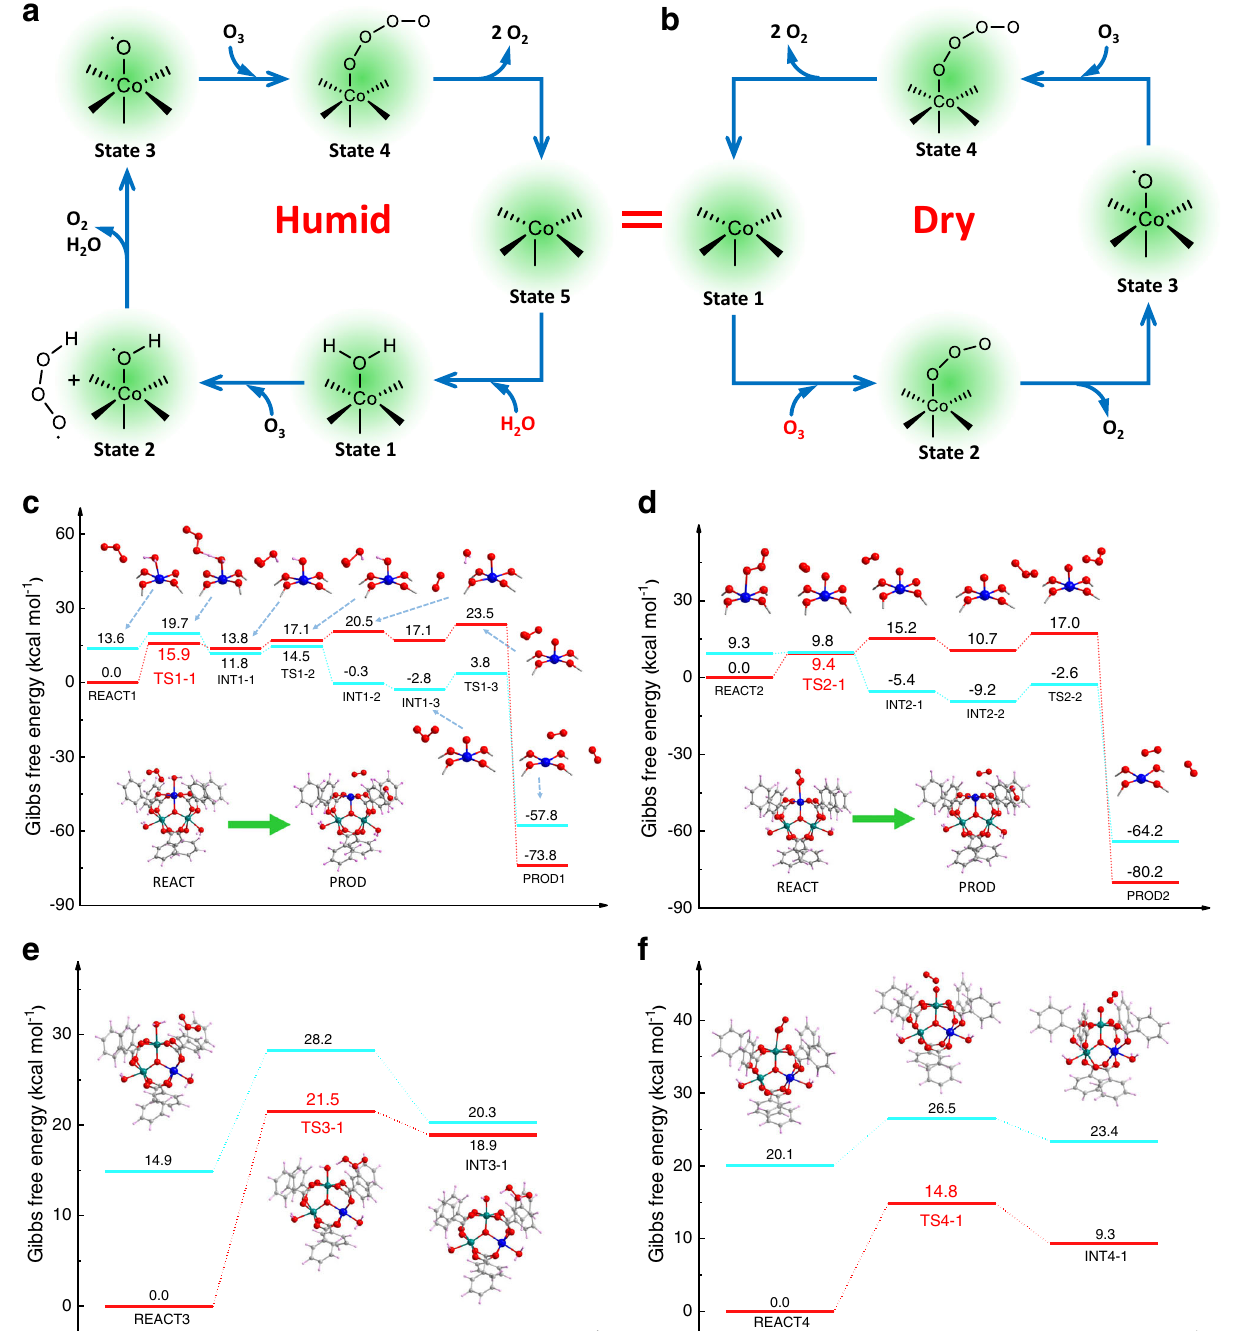
Fig. 4 | O 3 decompositionmechanismexploration. Proposed reactionpathways, energy pro fi les, and stationary-point structures along the calculated reaction pathways for the O 3 decomposition catalyzed at the Co(II) site of PCN-250(Fe 2 Co) underboth a , c humidand b , d dryconditions.Energypro fi lesandstationary-point